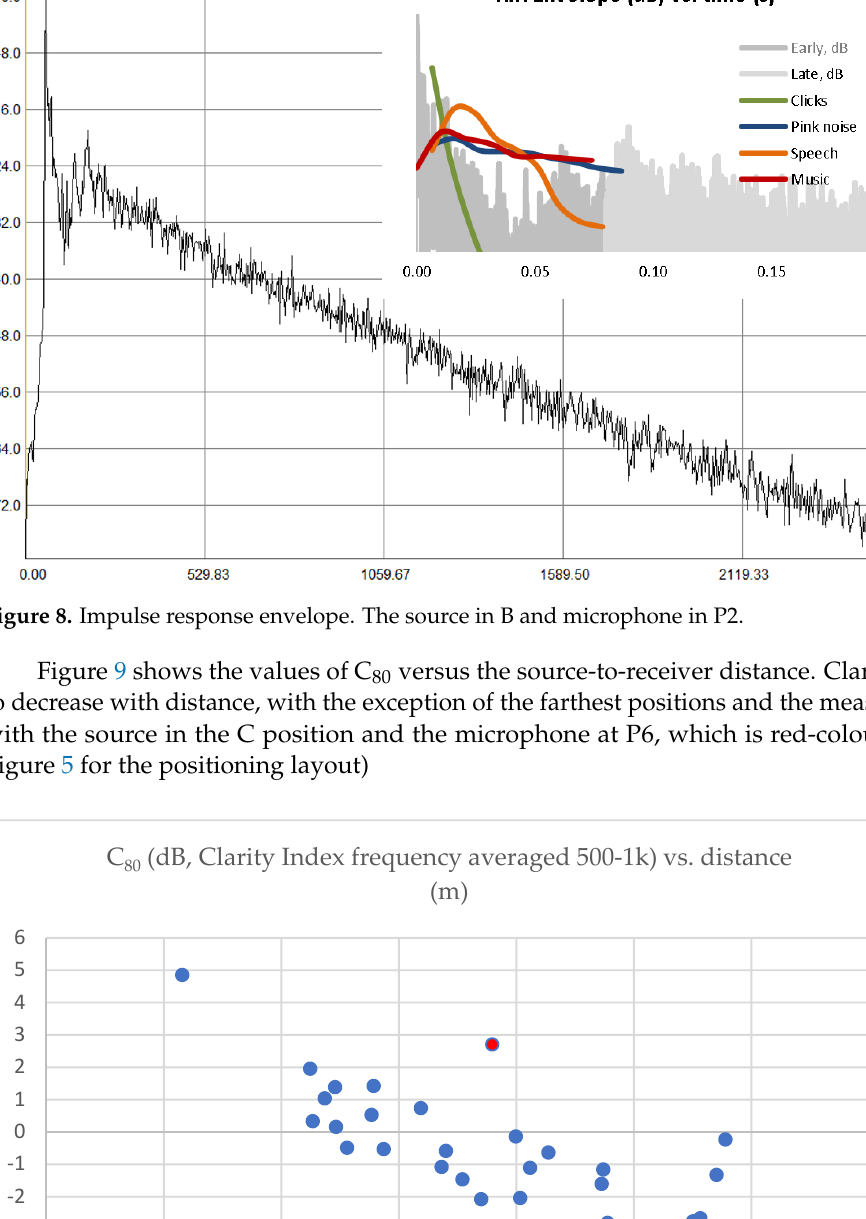
11 Table 6. Reverberation times and energy ratios (stage). f, (Hz)